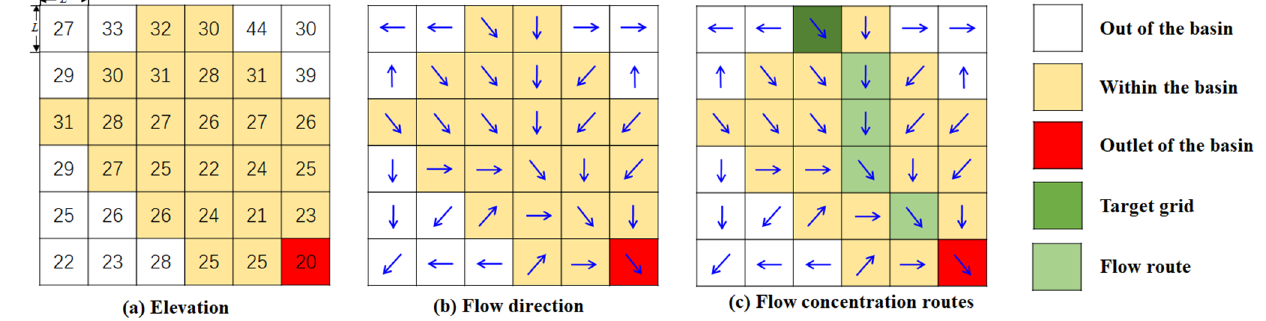
Figure 3. Flow direction and flow concentration routes.